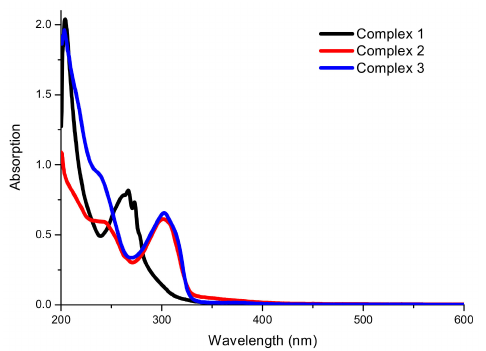
Figure 8. UV-vis spectra of complexes 1 – 3 in methanol.